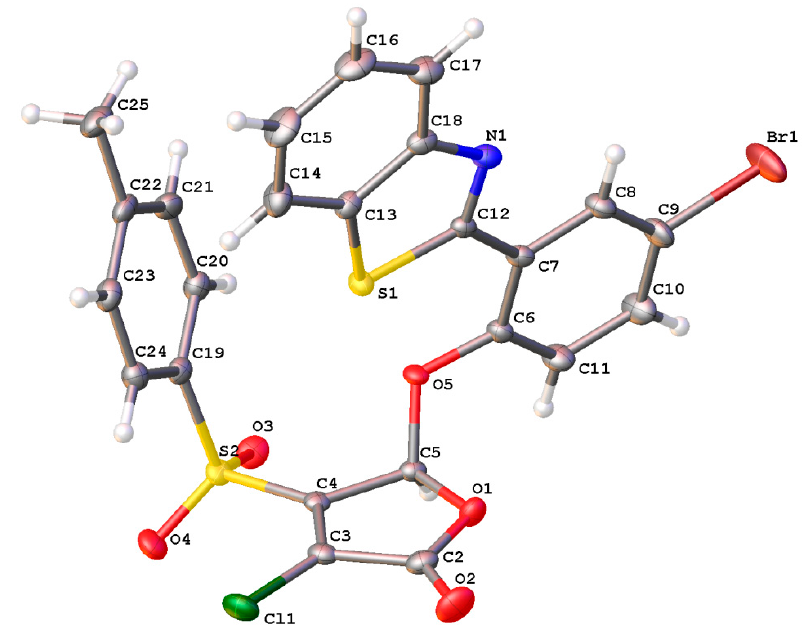
Figure 2. Molecular structure of compound 6 ( F145 ) in the crystal.